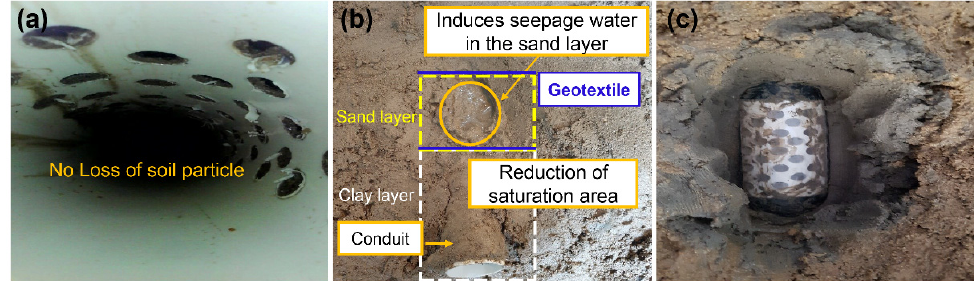
Figure 6. Reinforced conditions of improvement model (Case 2—Reinforcement): ( a ) zero loss of soil particles due to reinforced geomembrane, ( b ) reduced wet area in the downstream slope, and ( c ) stability against erosion in the filling zone near the conduit.